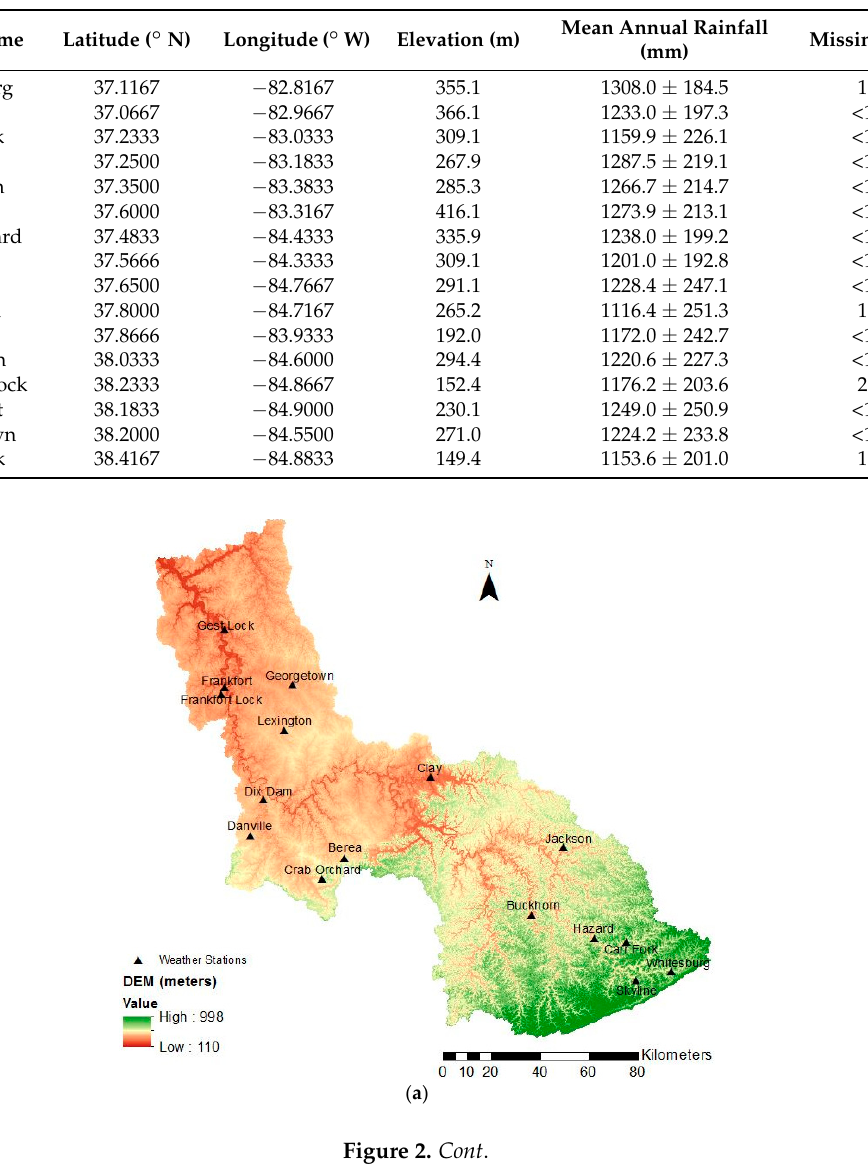
Table 1. Weather stations used in the study.